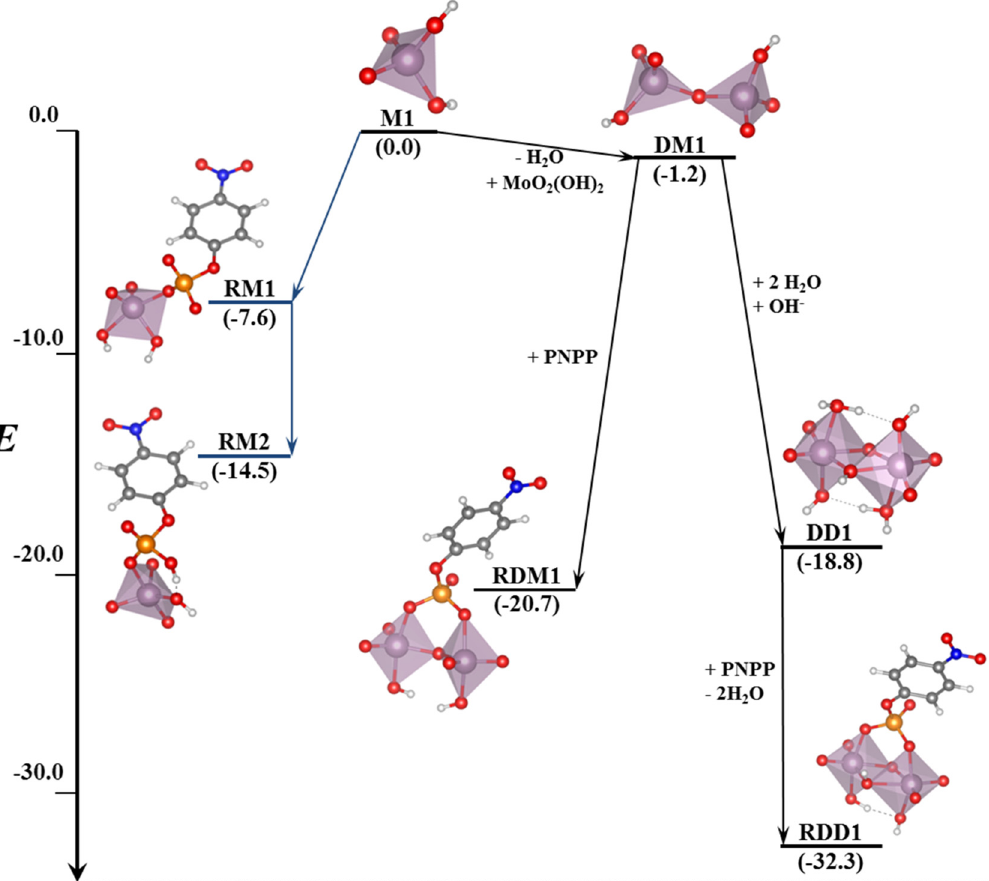
Figure 39. Comparison between the incorporation of pNPP to the mononuclear and to the dinuclear species at B3LYP/6- 311++G(3df,2p)//B3LYP/6-31+G** level of calculation by using solvent effects with the PCM approach. The relative Gibbs free energies are in kcal mol − 1 .